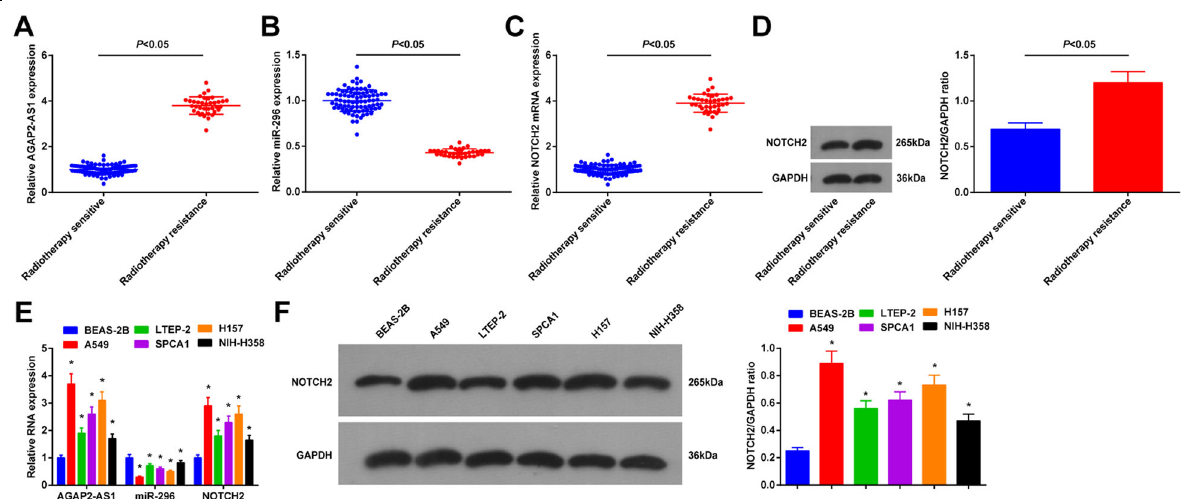
Fig. 1 AGAP2-AS1 and NOTCH2 increase while miR-296 decreases in lung cancer cells and tissues. A AGAP2-AS1 expression in lung tissues from radiosensitive patients ( n = 84) and radioresistant patients ( n = 37). B miR-296 expression in lung tissues from radiosensitive patients ( n = 84) and radioresistant patients ( n = 37). C NOTCH2 expression in lung tissues from radiosensitive patients ( n = 84) and radioresistant patients ( n = 37). D Protein expression of NOTCH2 in lung tissues from radiosensitive patients ( n = 84) and radioresistant patients ( n = 37). E Expression of AGAP2-AS1, miR-296, and NOTCH2 in lung cancer cell lines ( N = 3). F Protein expression of NOTCH2 in normal lung epithelial cell BEAS-2B and lung cancer cell lines ( N = 3); * P < 0.05 vs. BEAS-2B cells; the measurement data were expressed as mean ± standard deviation, unpaired t test was performed for comparisons between two groups, one-way ANOVA was used for comparisons among multiple groups and Tukey ’ s post hoc test was used for pairwise comparisons after one-way